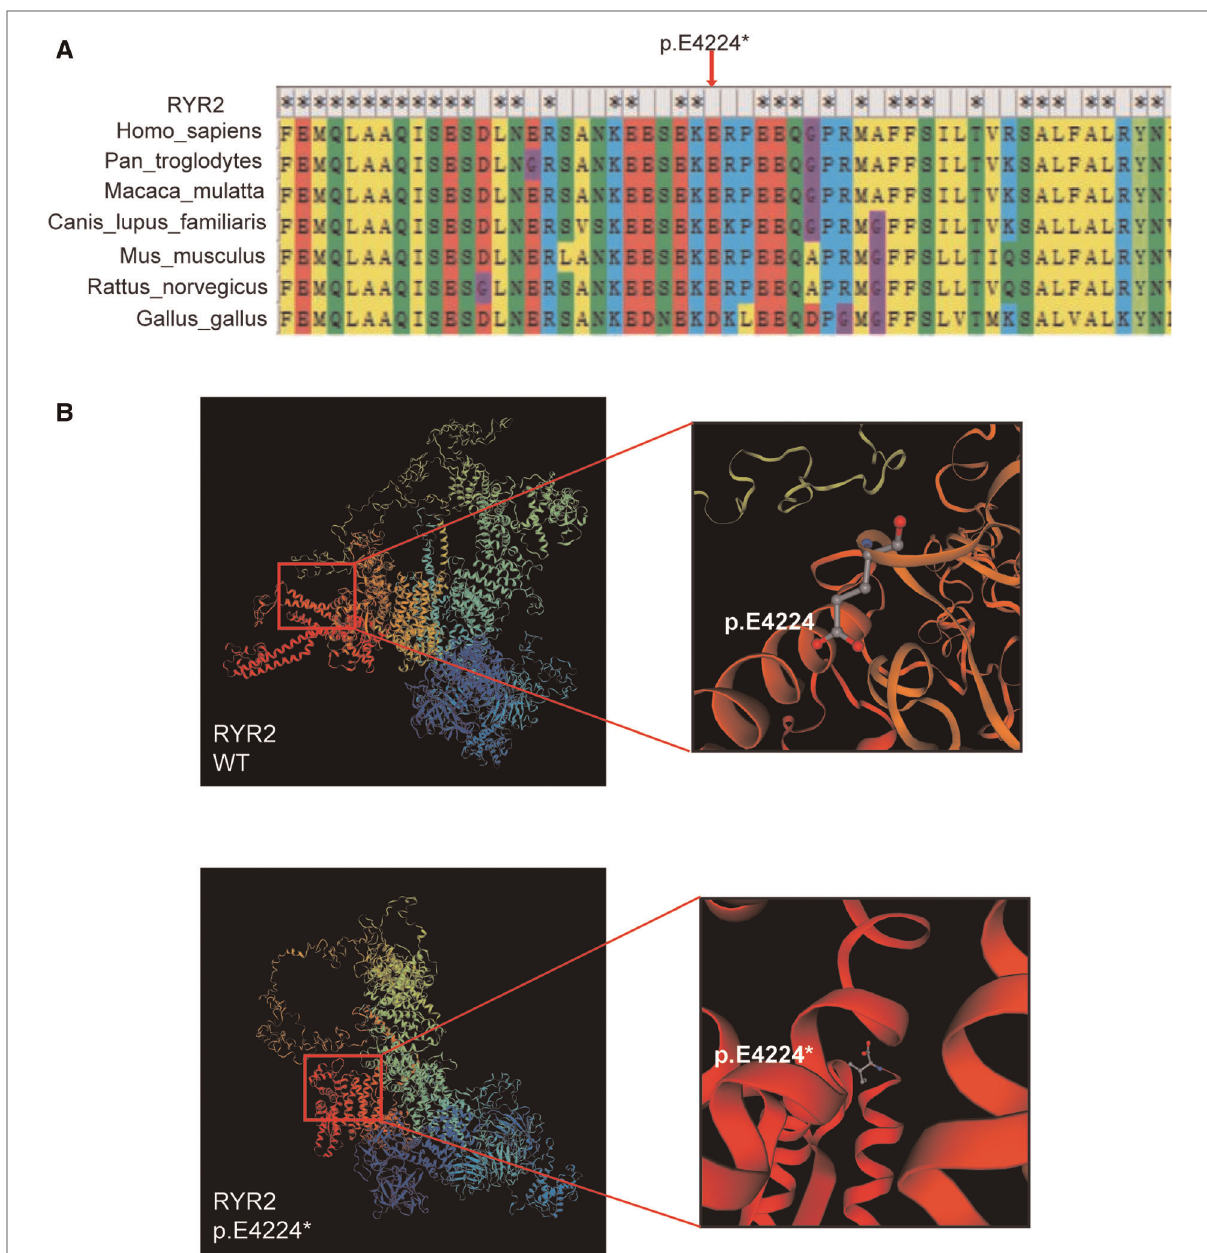
FIGURE 3 Bioinformatics analysis. ( A ) The multi-species alignment near the site of p .E4224. ( B ) The variant type of p .E4224* and wild-type tertiary structures of RYR2 protein predicted by